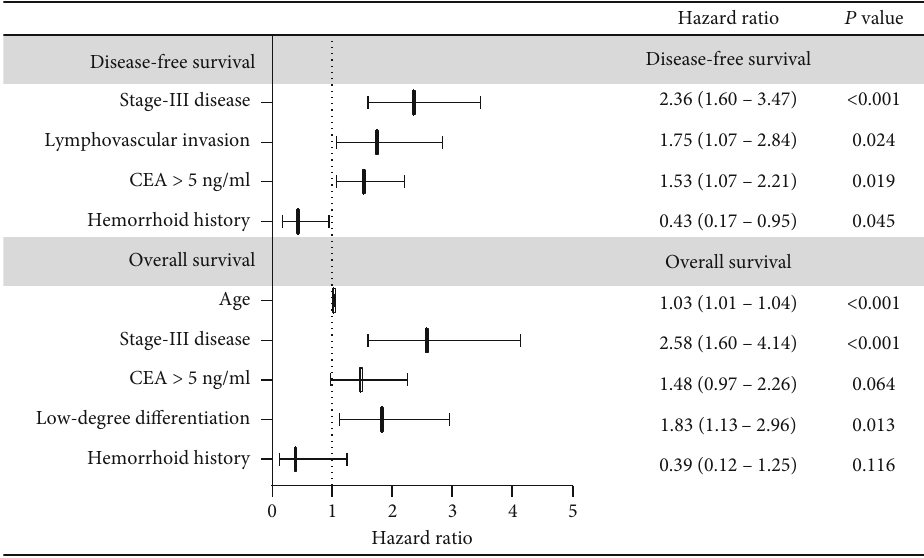
Figure 3: Multivariate analysis of prognostic factors for DFS and OS. The forest plot for the hazard ratios and 95% con fi dence intervals of each predictor in the multivariate Cox model for DFS and OS. CEA: carcinoembryonic antigen. HR: hazard ratio; CI: con fi dential interval.